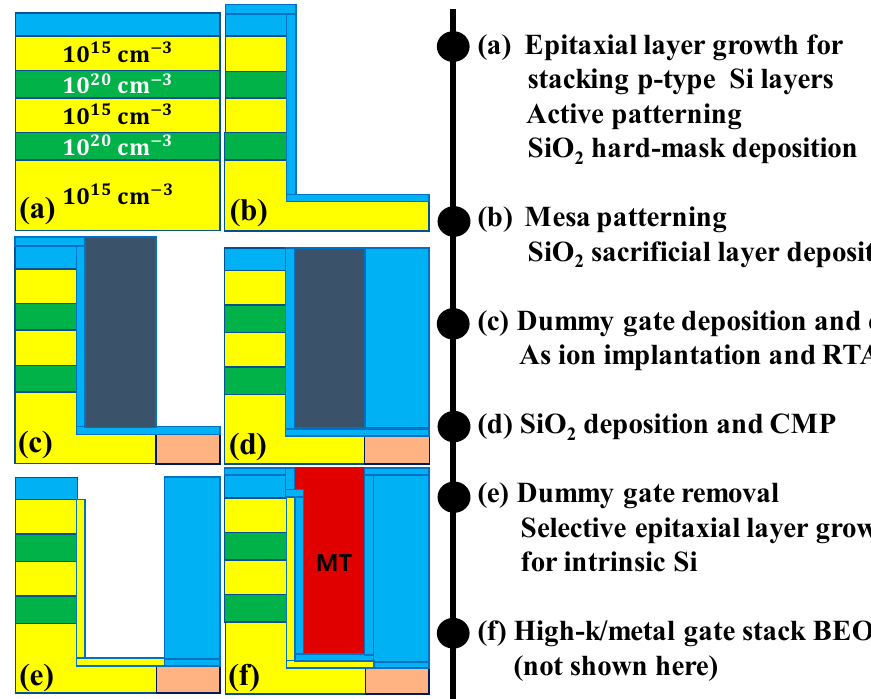
Figure 6. ( a ) Structure of L-shaped TFET. ( b ) Transfer characteristics of L-shaped and F-shaped TFETs at V DS = 0.7 V. The inset figure shows V ON of both TFETs as a function of L T from 2 to 8 nm.